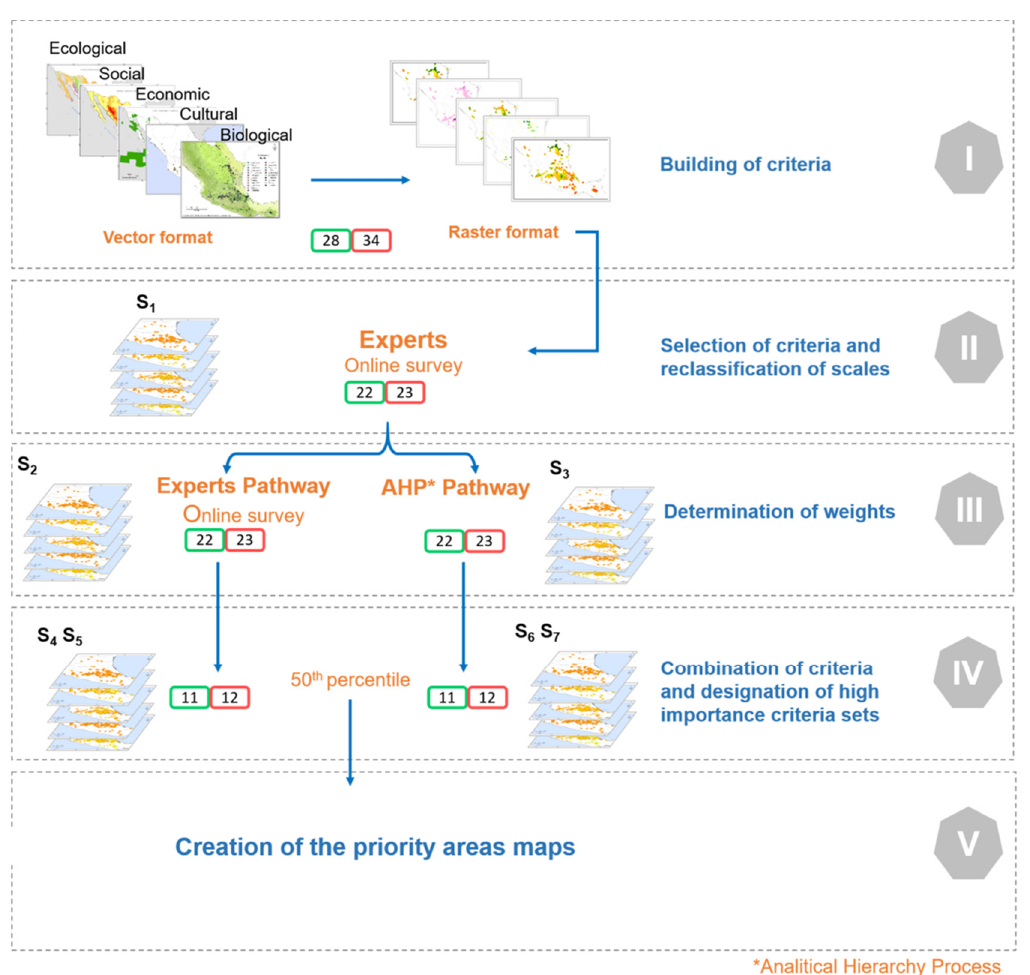
Figure 4. Process for the identification of priority areas for the in situ conservation of wild hawthorn ( Crataegus spp.) and cultivated hawthorn ( C. mexicana ) in Mexico. The green and red boxes indicate the number of criteria considered for both wild and cultivated hawthorn at each stage of the process, respectively. S 1 , S 2 , S 3 , S 4 , S 5 , S 6 , and S 7 represent the comparison scenarios.